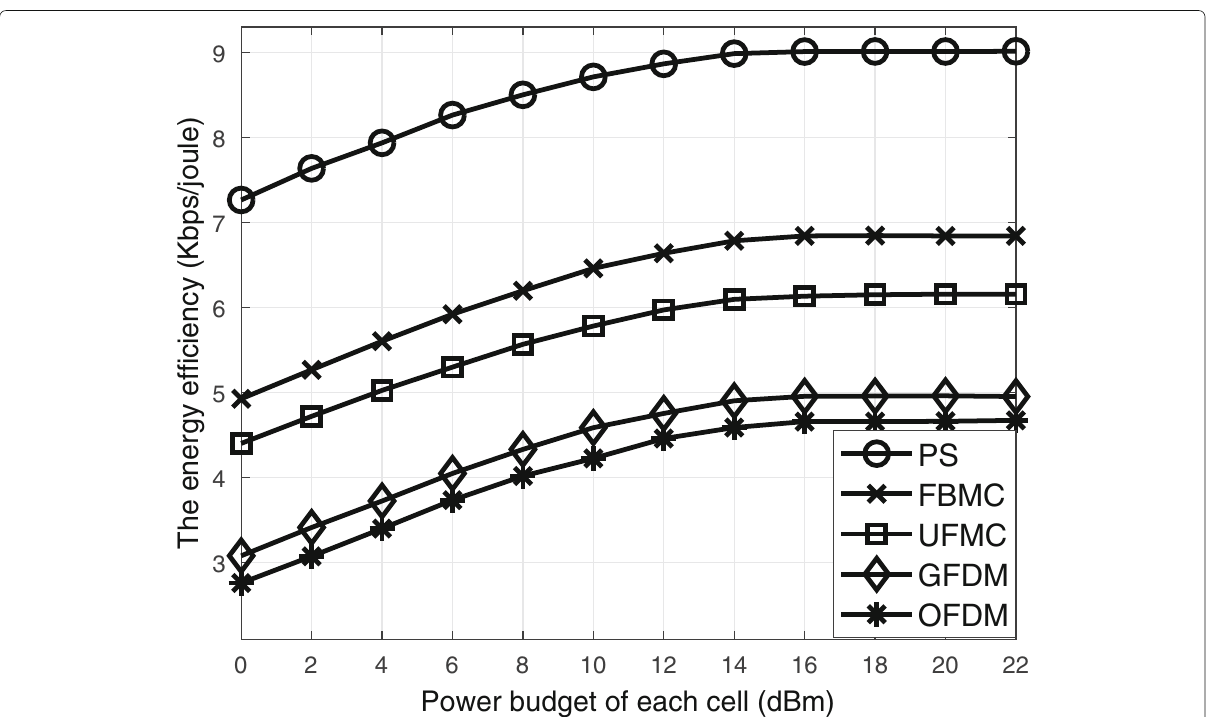
Fig. 6 Energy efficiency versus power budget. The performance of the proposed algorithm using various modulation schemes versus different sum power budgets